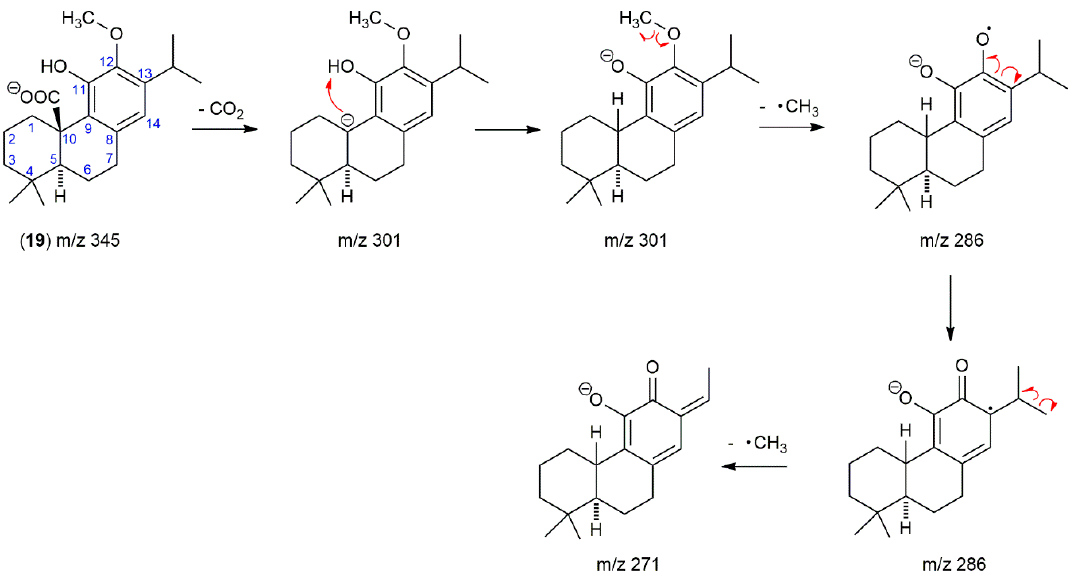
Figure 3. The suggested fragmentation of the deprotonated molecule of 12- O -methylcarnosic acid in the negative ion